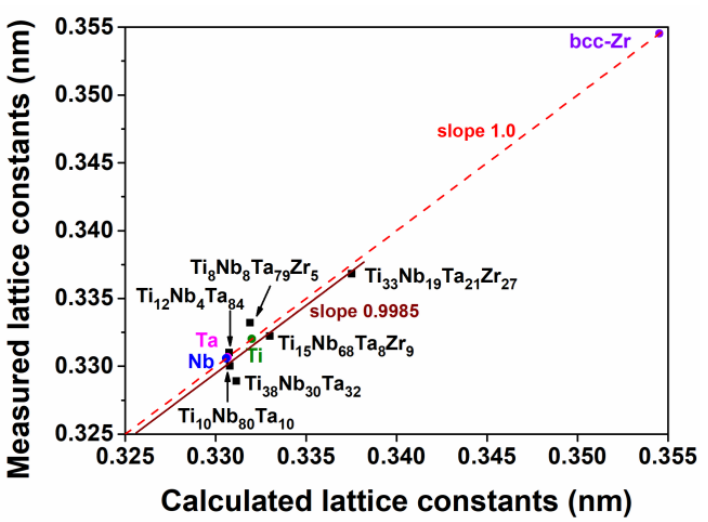
Figure 2. ( a ) XTEM image, ( b ) SAED pattern, and ( c ) HRTEM image of the Ti 83 Nb 10 Ta 7 film prepared on Si substrate.